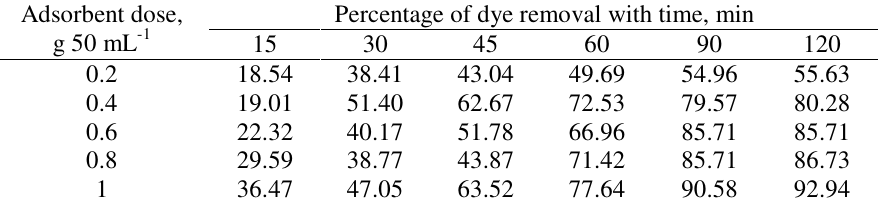
Table 3. Effect of adsorption dose on the dye